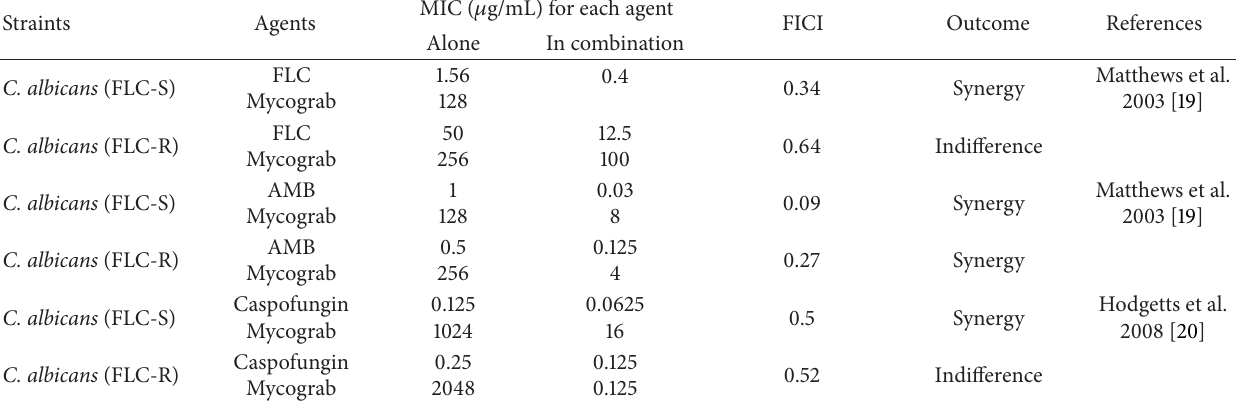
Table 1: Checkerboard assay of FLC (fluconazole), AMB, caspofungin, and Mycograb versus C. albicans fluconazole-susceptible (FLC-S) and fluconazole-resistant (FLC-R)